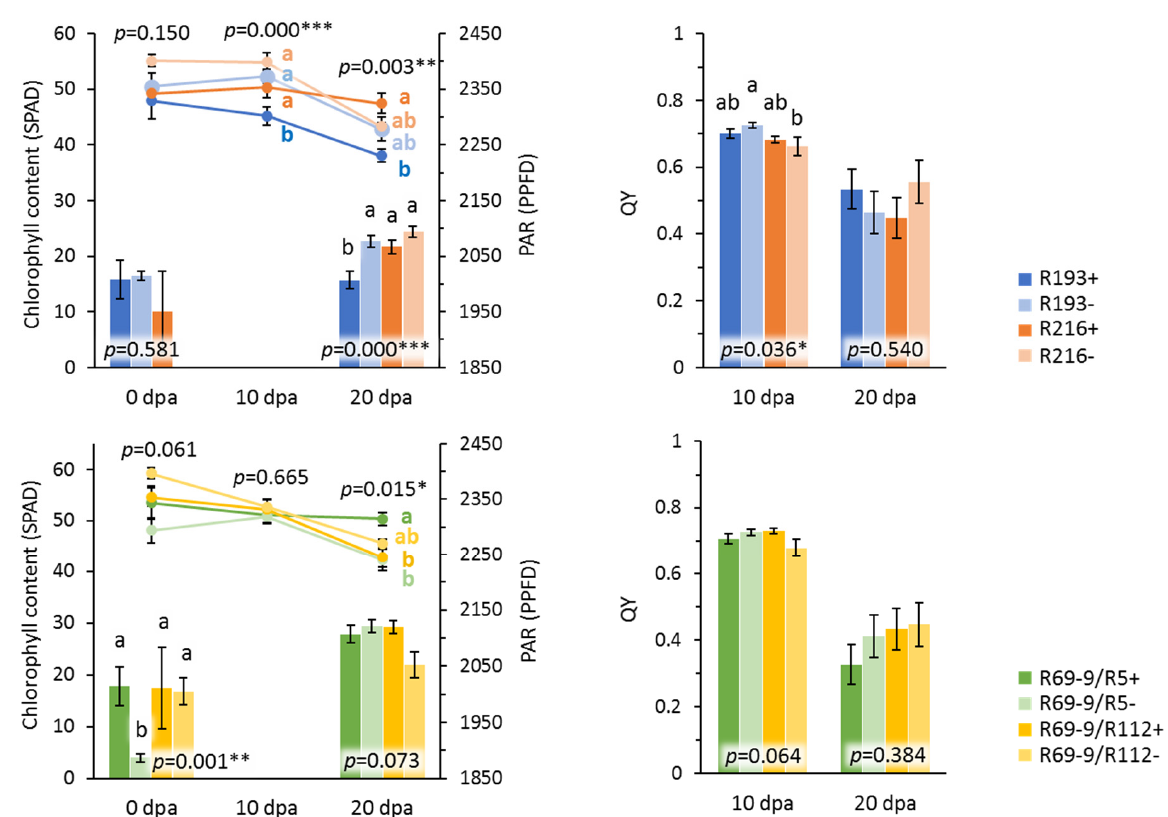
Figure 5. Flag leaf physiological traits measured for 7el 1 L + 7el 2 L and 7el 1 L + 7EL recombinants (hom+) and their controls (hom − ) in 2020 (PAR, photosynthetically active radiation; PPFD, photosynthetic photon flux density; QY, quantum yield of PSII). On the left, line graphs represent chlorophyll content, and histograms represent PAR; error bars represent standard errors of means; *, **, ***, significance at p < 0.05, 0.01 and 0.001 level, respectively.